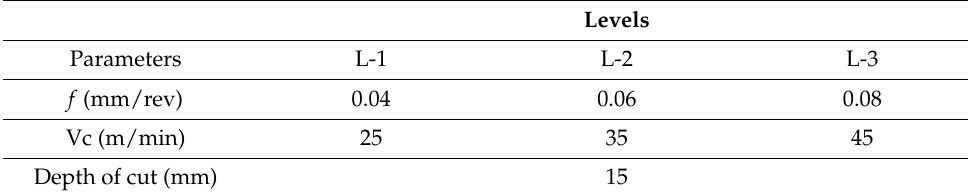
Table 3. Levels of input parameters.